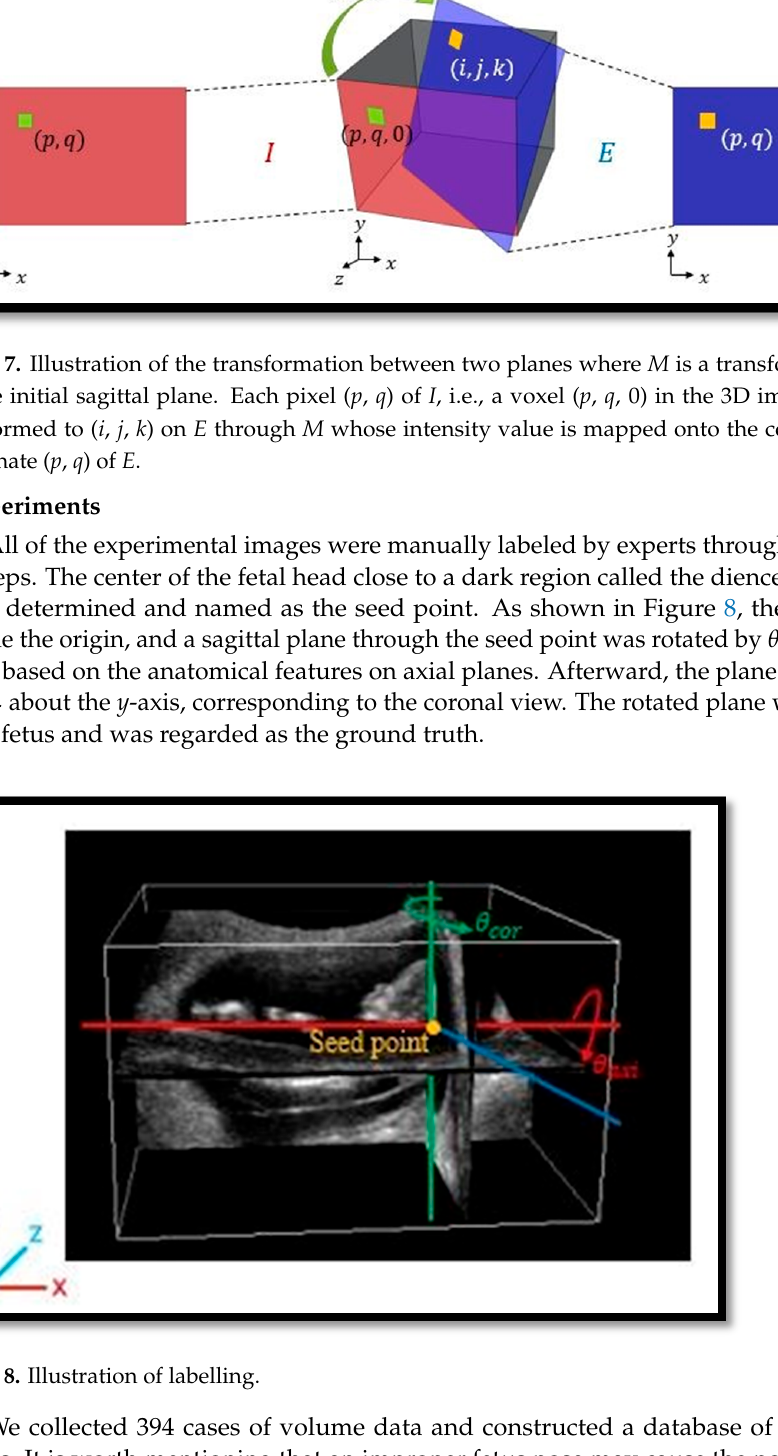
Figure 8. Illustration of labelling.